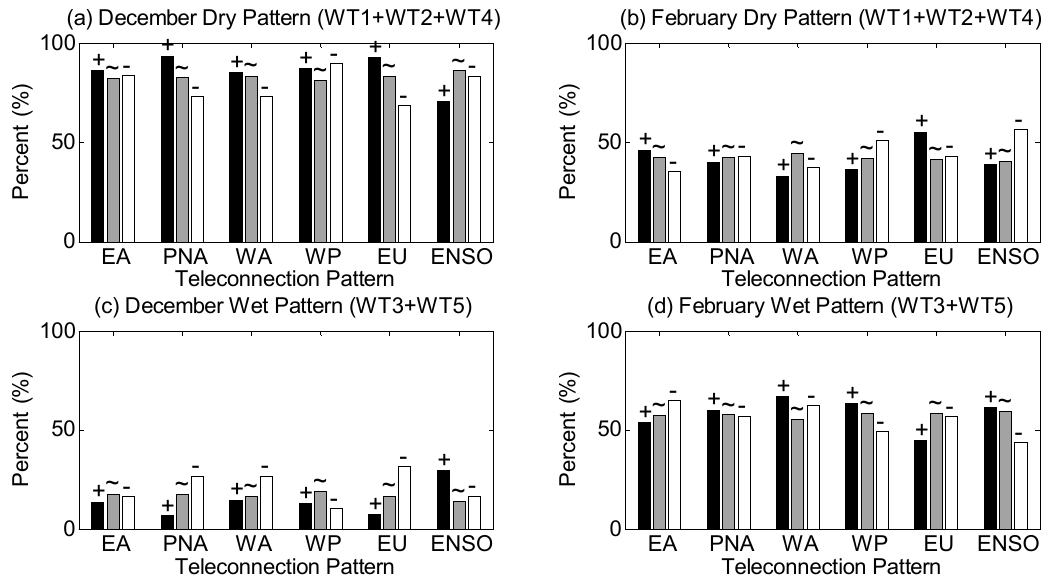
Figure 8. Intraseasonal variation of frequencies of different WTs (Dry and Wet). Frequencies for ( a ) December Dry Pattern (WT1 + WT2 + WT4), ( b ) February Dry Pattern (WT1 + WT2 + WT4), ( c ) December Wet Pattern (WT3 + WT5), and ( d ) February Wet Pattern (WT3 + WT5) during various phases of the teleconnection patterns. For each teleconnection pattern, the three bars represent the positive ( + ), neutral (~), and negative ( − ) phases.